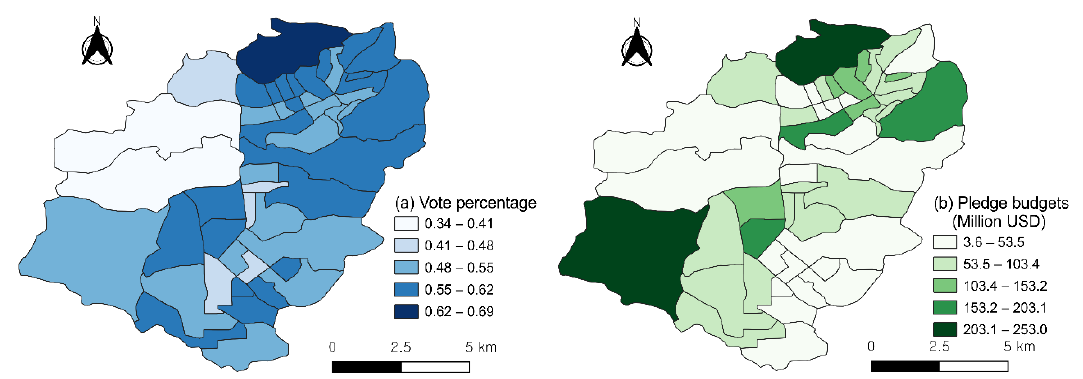
Figure 1. Registered voters and turnout. Land 2020 , 9 , x FOR PEER REVIEW